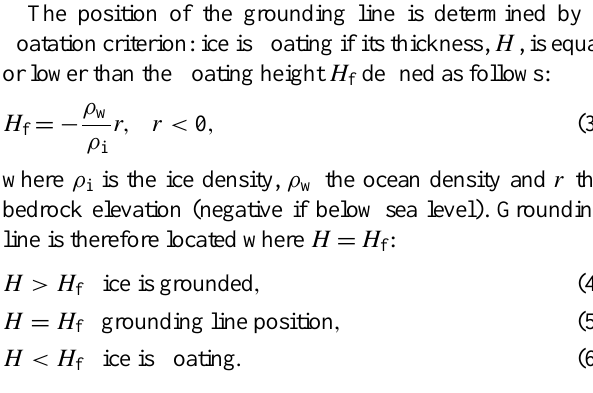
Fig. A1. Grounding line discretization. Grounding line exact location (a), no sub-element parameterization (NSEP, b), sub-element parame- terization 1 (SEP1, c), sub-element parameterization 3 (SEP2, d) and sub-element parameterization 3 (SEP3,e).